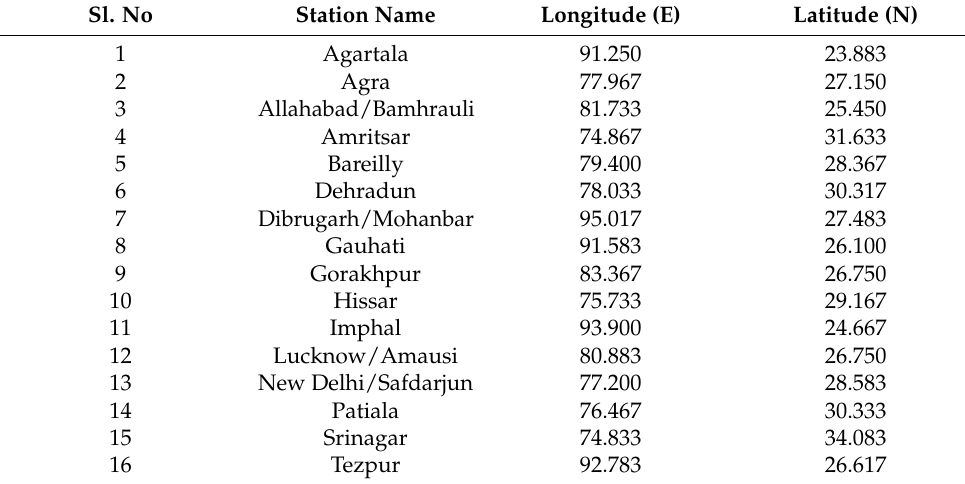
Table 1. List of observation